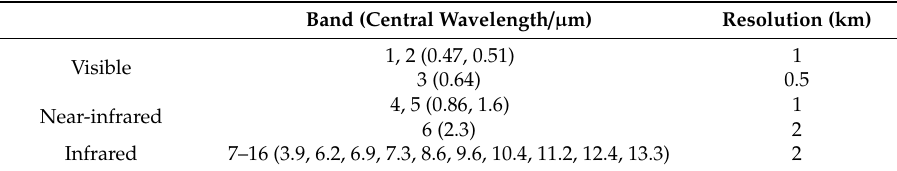
Table 1. Information about Himawari-8 Advanced Himawari Imager (AHI)